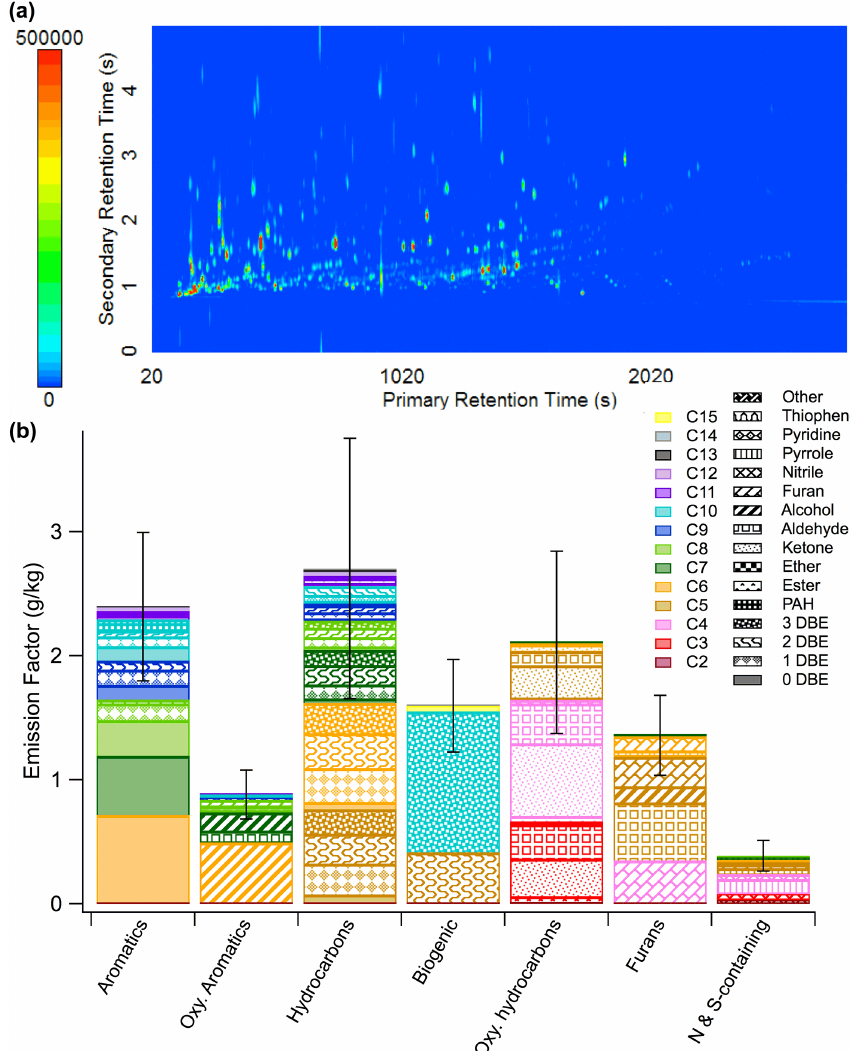
Figure 2. As in Fig. 1, for a ponderosa pine